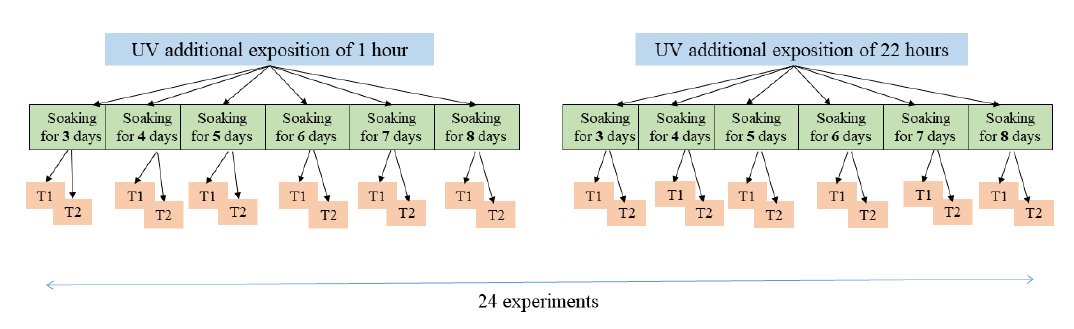
Figure 2. Experiments post-processing plan scheme: T1, 22–25 ◦ C ; T2, 37–40 ◦ C. First, polymerized structures were additionally UV exposed for 1 or 22 h. Then, samples were soaked in two different solvents for different duration from one to eight days at two different